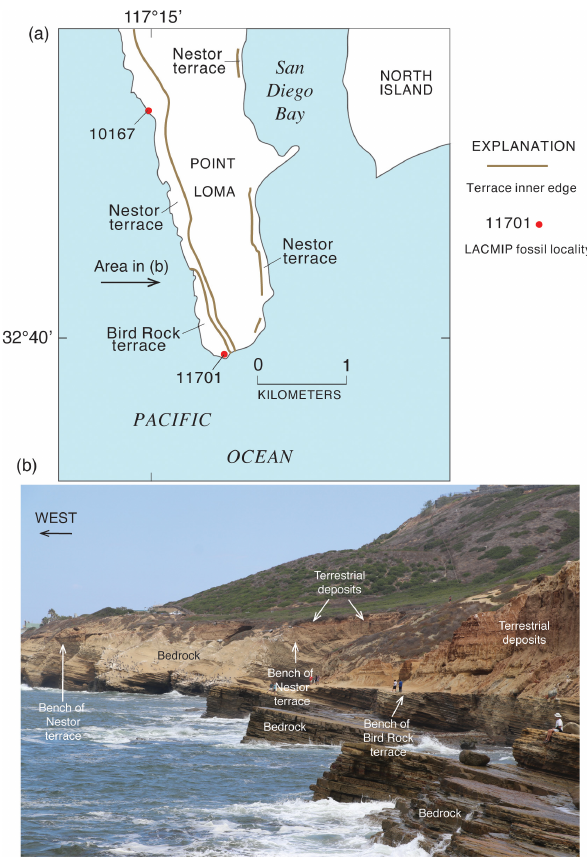
Figure 29. (a) Map showing marine terrace inner edges (redrawn from Kern, 1977) and LACMIP fossil localities where U-series ages are reported by Muhs et al. (1994, 2002a); corals from the Nestor terrace date to ∼ 120ka (MIS 5e) and ∼ 100ka (MIS 5c); those from the Bird Rock terrace date to ∼ 80ka (MIS 5a). (b) Photo- graph showing outer edges of the Nestor and Bird Rock terraces on the west coast of Point Loma, looking north (see location in a ). Photograph by Daniel R.